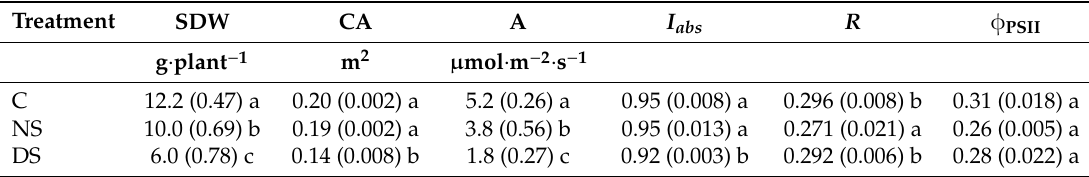
Table 2. Shoot dry weight (SDW), canopy area (CA), leaf photosynthesis (A), light absorption fraction ( I abs ), N stress index (R) and quantum e ffi ciency in light ( φ PSII ) of petunia at harvest stage in the control (C), nitrogen stress (NS) and drought stress (DS) treatments. Treatment means followed by the same letter are not statistically di ff erent ( p ≤ 0.05). Values in parenthesis indicate standard error of mean.